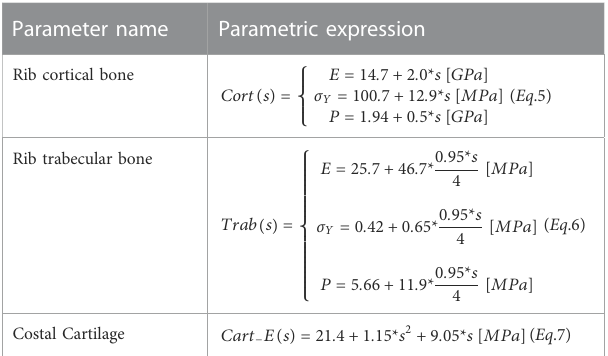
TABLE 2 Parametric expressions for scaling material model parameters of ribs and costal